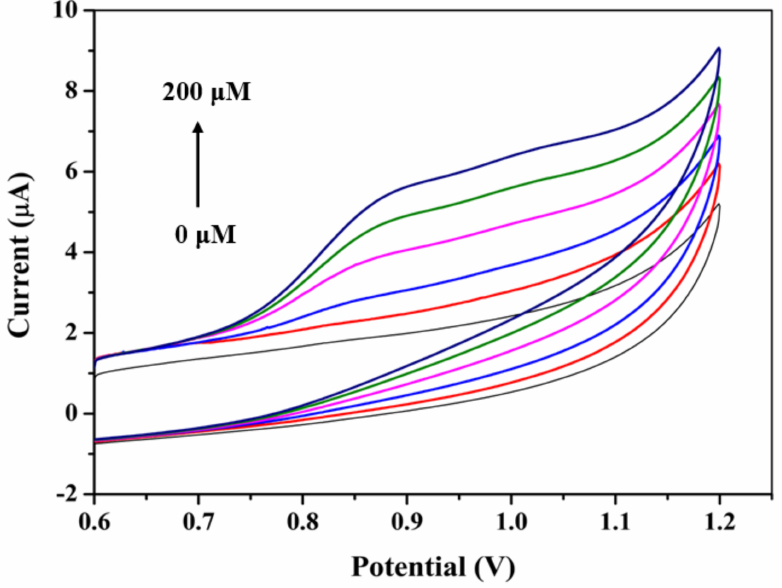
Figure 9. Cyclic voltammograms were recorded using Ag-NPs/GCE with different concentration of NIC (0 µ M, 10 µ M, 50 µ M, 100 µ M, 150 µ M and 200 µ M) in 0.1 M PBS at a scan rate of 50